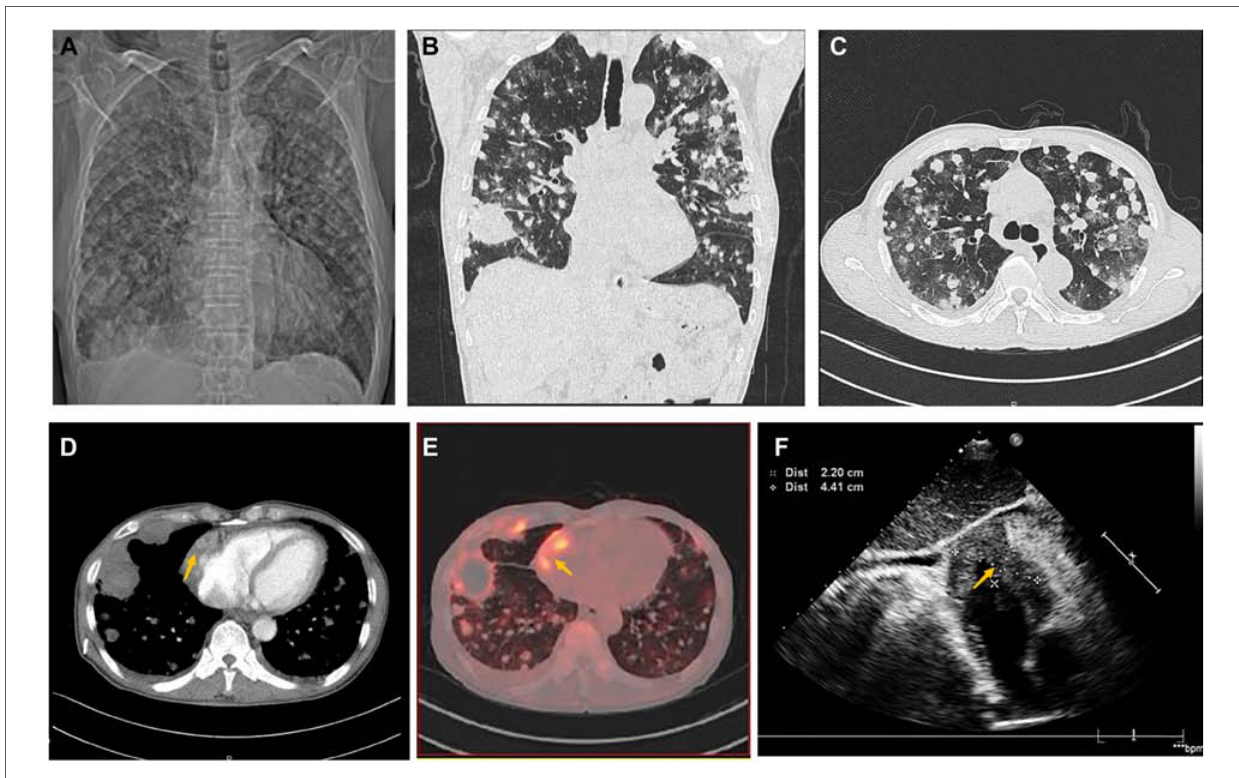
FIGURE 1 Chest computed tomography demonstrated cardiac mass of Case1. ( A ) Chest x-ray and Chest CT images in axial ( B ) and coronal planes ( C ) showed remarkable extensive pulmonary lesions. ( D ) Contrast-enhanced CT showed a hypodense oval fi lling contrast defect (arrow) at the right atrium (RA). ( E ) 18F- fl uorodeoxyglucose positron emission tomography/CT (18F-FDG PET/CT) showed more uptake in the RA mass (arrow), lung, and pleura. ( F ) Echocardiography depicted an oval-shaped mass (22×41 mm) (arrow) in the RA at the level of the superior vena cava